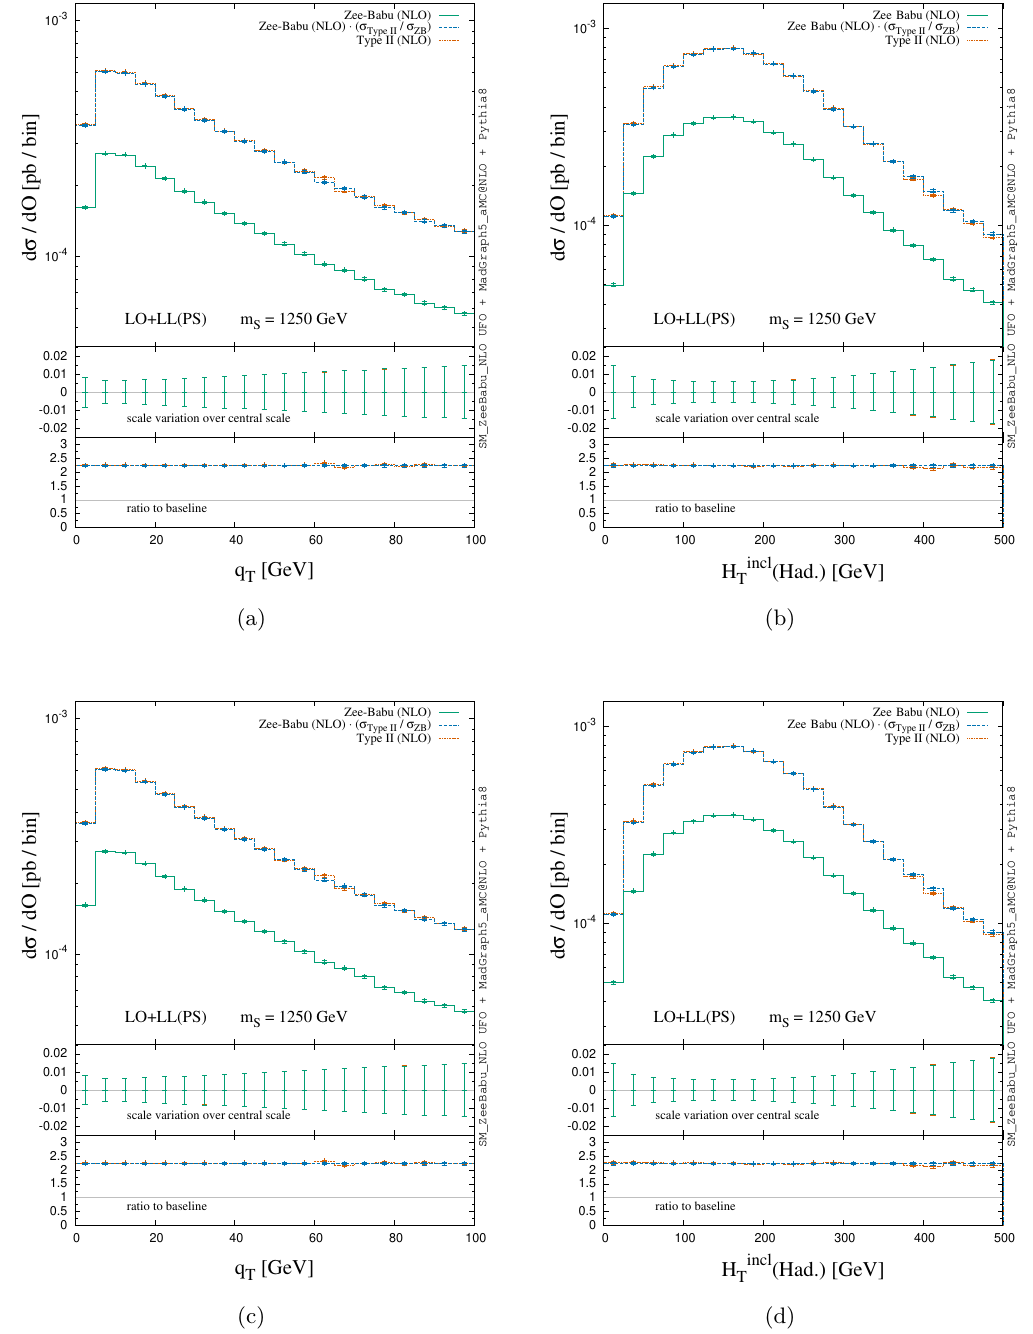
Figure 8 . (a,b) Same as figure 6 but for shapes Q T and H incl (a,b) but for m S = 1250 GeV